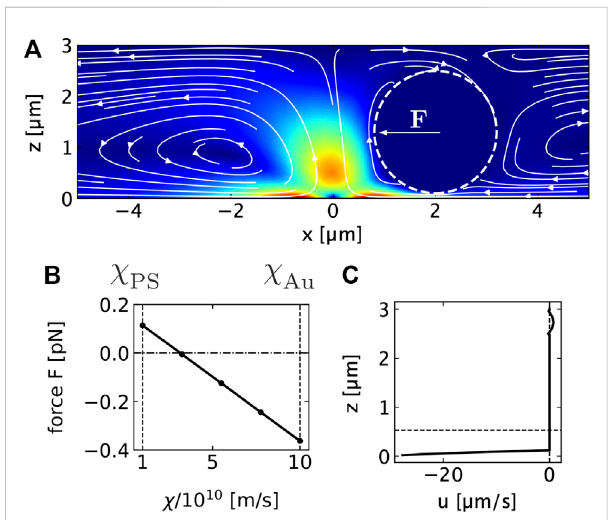
FIGURE 4 (A) Thermo-osmotic fl ow fi eld generated by heating a thin gold fi lmwithaGaussianbeamat x = z =0 μ mincontactwitha3 μ mwater fi lm. The color background shows the magnitude of the fl ow velocity. The lines indicate the streamlines. The dashed line is the circumference of the 2.38 μ m PS colloid placed in the fi lm. The arrow F indicatesthedirectionofthehydrodynamicforce. (B) Hydrodynamic force on the 2.38 μ m PS particle at x = 2 μ m distance from the heat source due to the fl ow in (A) . The hydrodynamic force is calculated fromtheintegralofthetotalstresstensoroverthespheresurface.The fl ow is the result of the local heating of the gold fi lm at the lower boundary to Δ T max = 50 K and a resulting thermo-osmotic creep fl ow using athermo-osmotic coef fi cient of χ Au = 10 · 10 – 10 m 2 s − 1 . The force is plotted vs. the thermo-osmotic coef fi cient χ at the polymer particle surface that is varied between the polystyrene ( ξ PS ) and the gold ( χ Au ) value. (C) Horizontal component of the thermo-osmotic fl ow velocity u calculated at x = 2 μ m. The diagram shows the strong shear fl ow between sphere and gold surface and the weak back fl ow above the